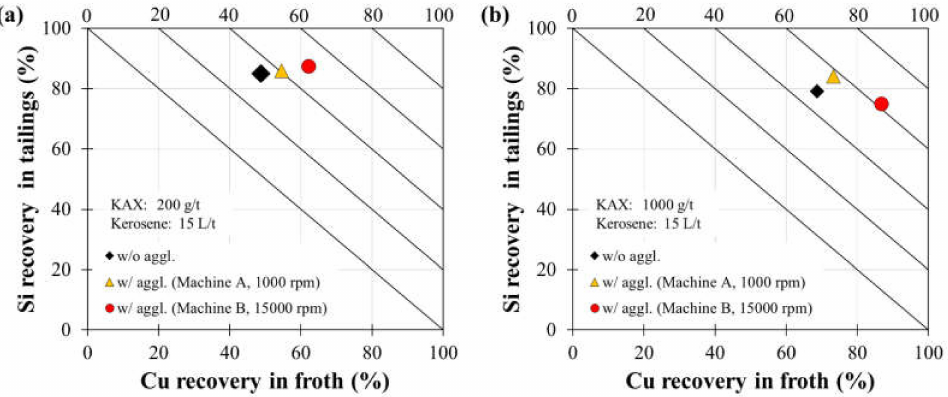
Figure 9. Relationship between Cu recovery in froth, R Cu (%), and Si recovery in tailing, R Si (%), of chalcopyrite and quartz mixture with di ff erent KAX dosage: ( a ) 200 g / t and ( b ) 1000 g / t. With increasing agitation strength and KAX dosage, Cu recovery increased significantly, while Si recovery in tailings was almost constant (around 20%). The separation e ffi ciency, η (%), which can be defined by Equation (1), increased with increasing agitation strength and KAX dosage. These results indicate that quartz may not a ff ect Cu recovery. Even with the presence of quartz, Cu recovery increases with increasing agitation strength and KAX dosage, resulting in the improvement of separation e ffi